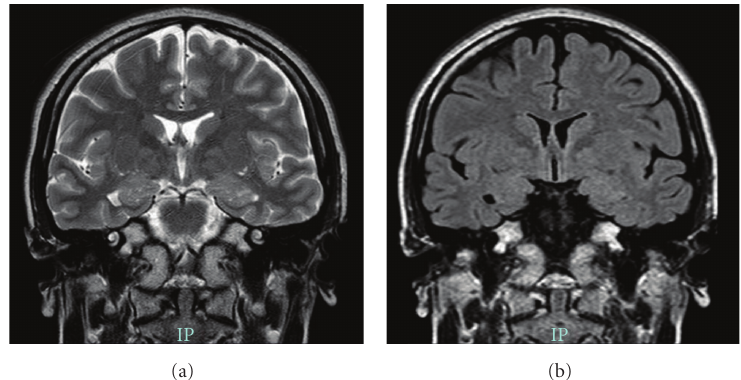
Figure 1: Follow-up MRI of the patient. Coronal fast spin-echo T2-weighted MR images (a) and FLAIR images (b) through the level of the Sylvian fissures show normal MRI study with disappearance of the previously noted cortical swelling and hyperintensity of the left cerebral hemisphere.